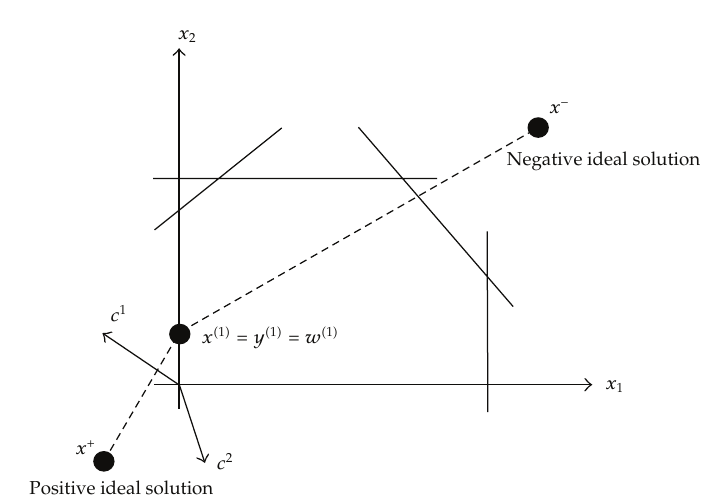
Figure 4: Compromise solution in iteration 2.